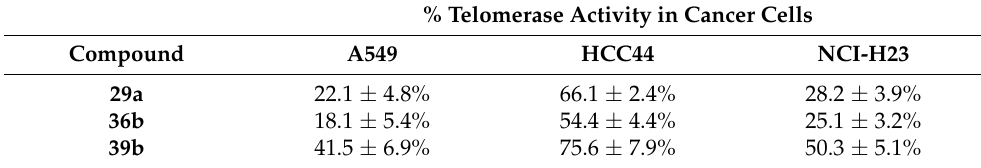
Table 2. Telomerase activity in cancer cells as a percent of control cells with target compounds 29a , 36b , and 39b . Table 2. Tel о mer а se а ctivity in c а ncer cells а s а percent о f c о ntr о l cells with t а rget c о mp о unds 29a , 36b , and 39b .